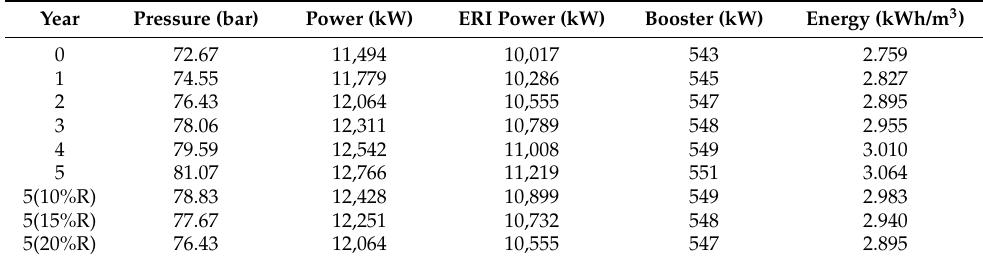
Table 8. Pressure, Power, and Energy consumption at 17 ◦ C.